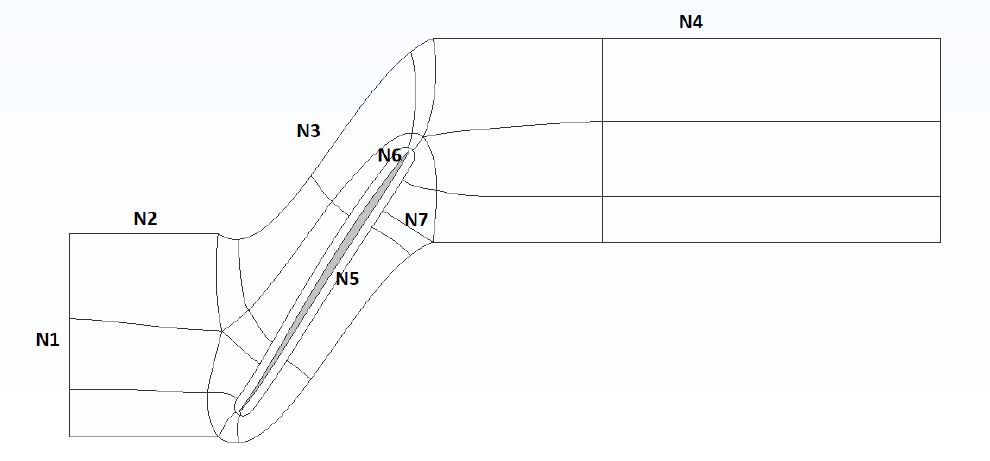
Figure 1. Scheme of the multi-block grid.